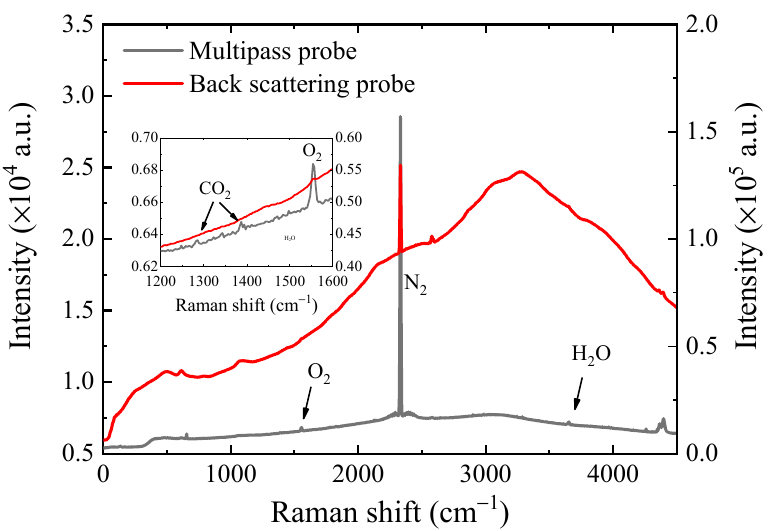
Figure 5. Result comparison of CERS probe and commercial backscattering Raman probe for 2000 ppm CO 2 and 1% O 2 .